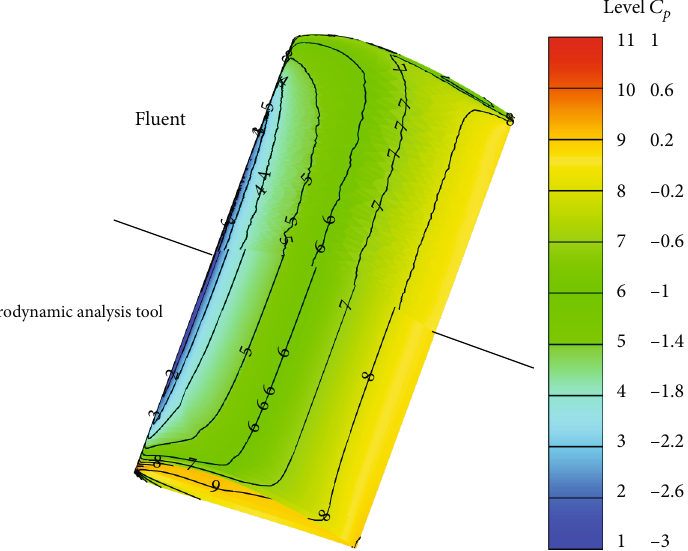
Figure 6: C contours of the aerodynamic analysis tool and ANSYS-Fluent for 10 ° p